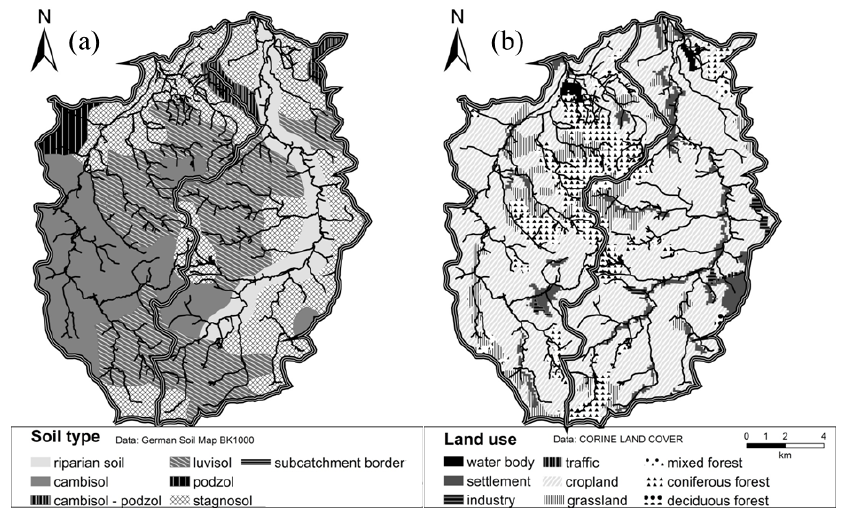
Fig. 1. General maps of the study region: (a) soil map, (b) land use map for the subcatchments of River Schwarzer Schoeps (left) and Weisser Schoeps